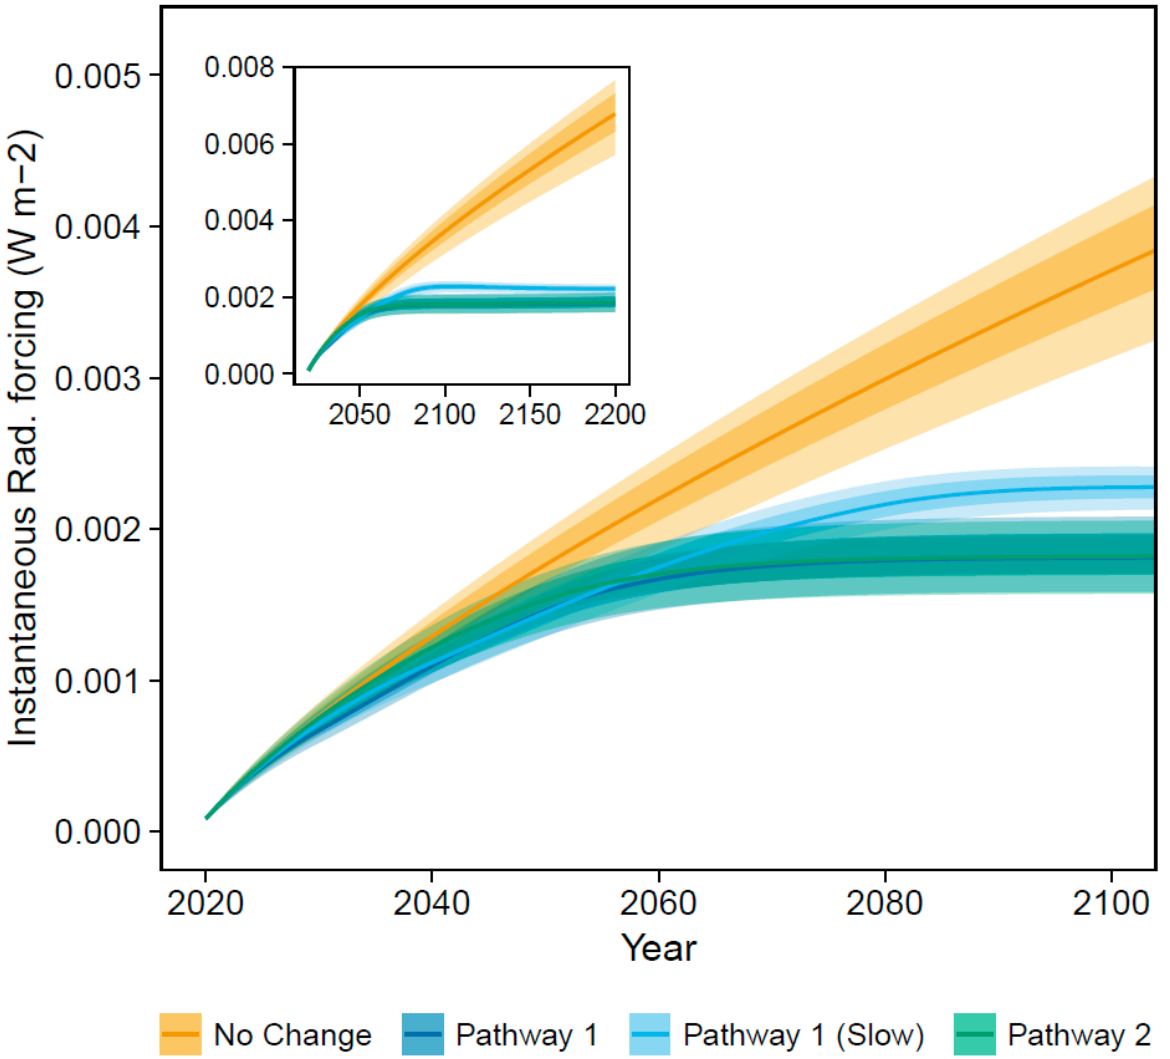
Figure 5. Combined climatic effects of peatland scenarios for Germany in the period until 2100 and 2200 (inset). Error ranges represent the range (minimum to maximum) of radiative forcing (RF) resulting from 10 and 20 % uncertainty of emission factor, represented by shading intensity. ‘Pathway 1’ = all rewetted by 2050 including a ‘moist’ stage, iii) ‘pathway 1 (slow)’ = all rewetted by 2080 including a ‘moist’ stage, and iv) ‘pathway 2’ = all rewetted by 2050 omitting a ‘moist’